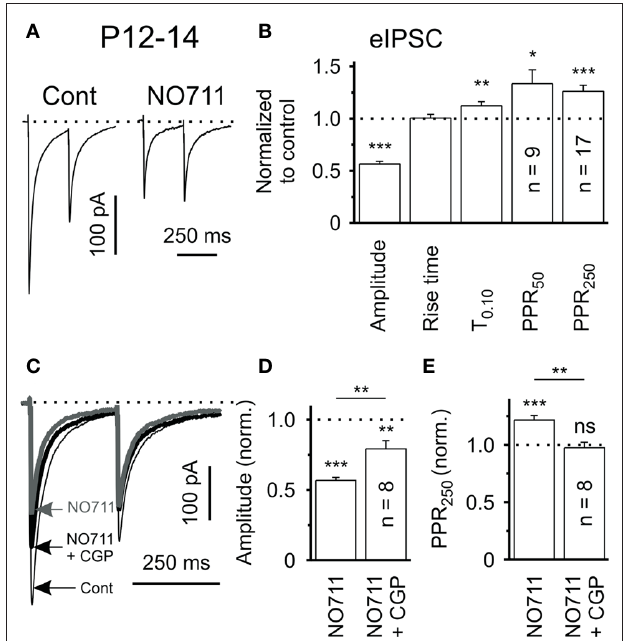
FiGurE 1 | Tonic activation of presynaptic GABA rs induced by GAT-1 B blockade in rat brain slices. (A) eIPSCs in response to paired-pulse stimulation (ISI 250 ms) in control solution and in the presence of the GAT-1 blocker, NO-711 (10 μm), in slices of P12-14 rats. Traces represent averages of 20 responses. (B) Quantification of results for NO-711 effects on the mean eIPSC amplitude, PPR (PPR : ISI 50 ms, PPR : ISI 250 ms), rise time 50 250 (20–80%) and decay ( T ) of striatal eIPSC. Data from 17 striatal output 0.10 neurons (SONs), except PPR . (C) Evoked IPSCs in response to paired-pulse 50 stimulation (ISI 250 ms) in control solution and in the presence of either NO-711 or NO-711 plus the GABA -receptor antagonist CGP55845 (1 μm). B Traces represent averages of 20 responses. (D,E) CGP55845 partially restored the NO-711-induced reduction in eIPSC amplitude and completely reversed the NO-711-induced increase in PPR (ISI 250 ms). ns – not significant, * P < 0.05, ** P < 0.01, *** P < 0.001. Reprinted from Kirmse et al. (2008) with permission from John Wiley